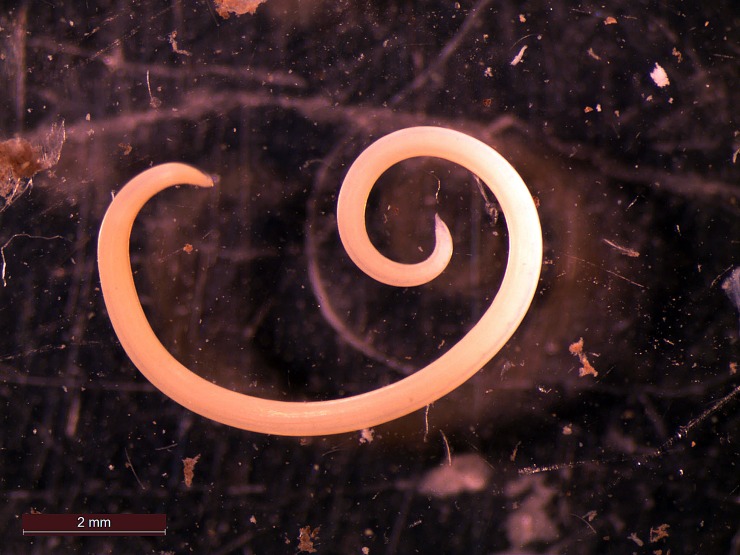
Ascaridid nematode dissected from the stomach wall of Bythaelurus stewarti n. sp., paratype, ZMH 26252, female, 295 mm TL.